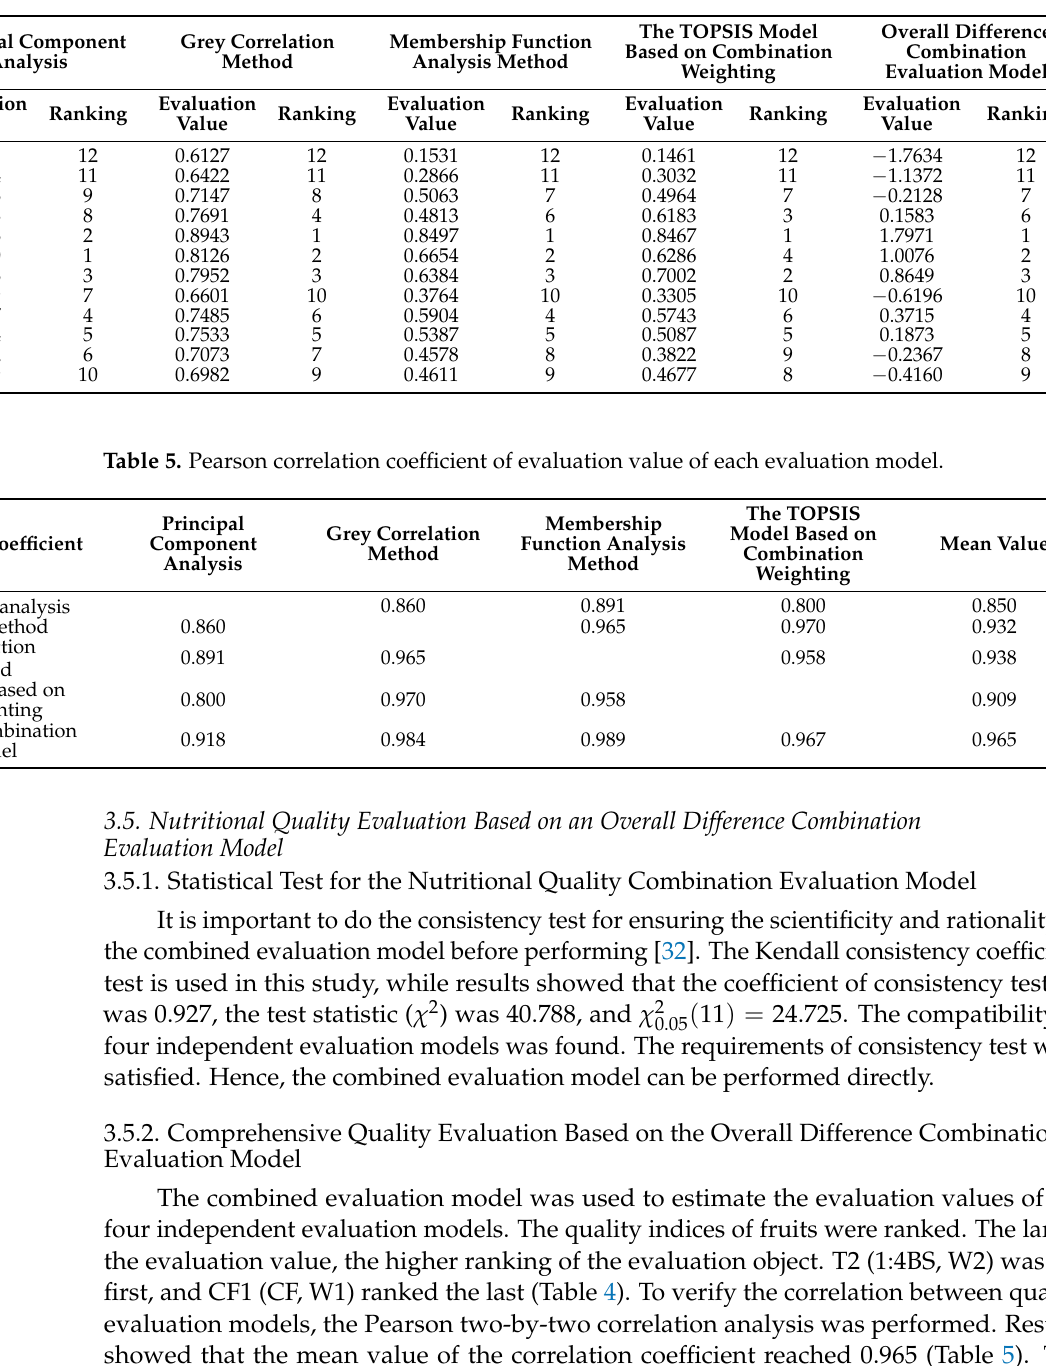
Table 4. Result of different evaluation models on comprehensive nutrition quality of tomato.